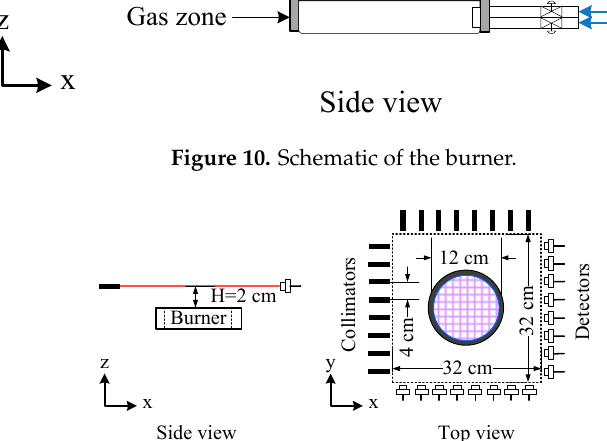
Figure 11. The geometric description of one burner to generate a symmetrical flame shape.